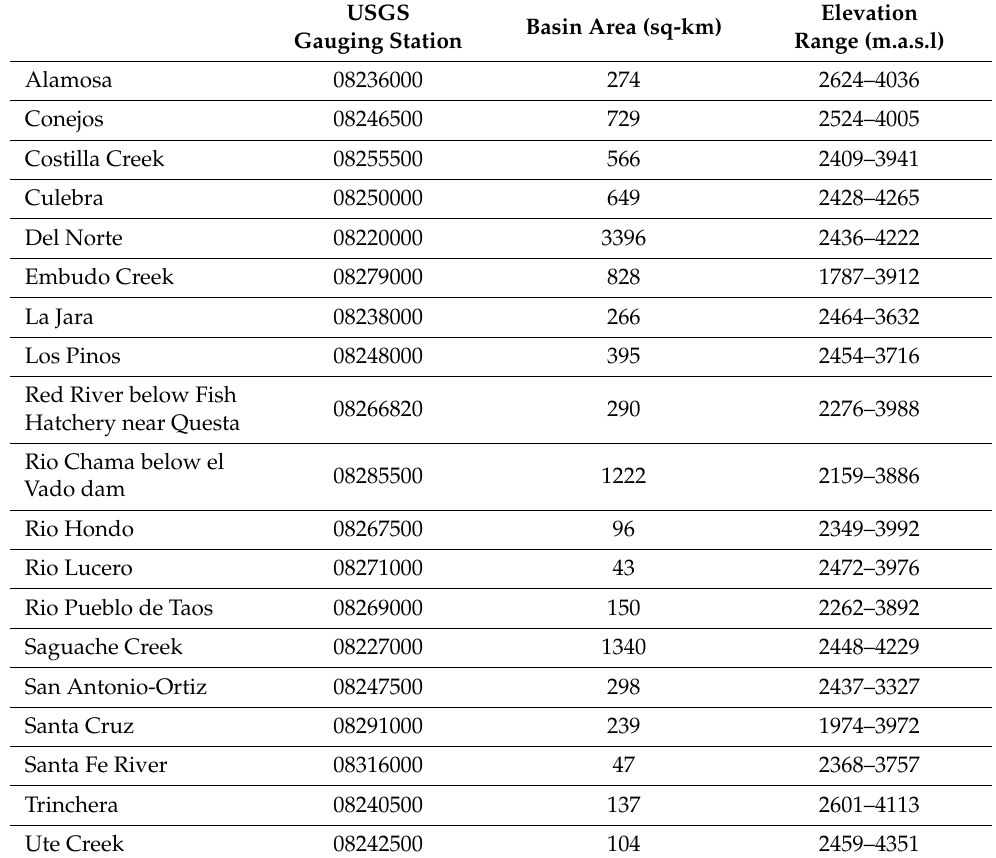
Table 1. Nineteen sub-watersheds in the URG basin and their associated USGS gauging station number, basin area, and elevation range.